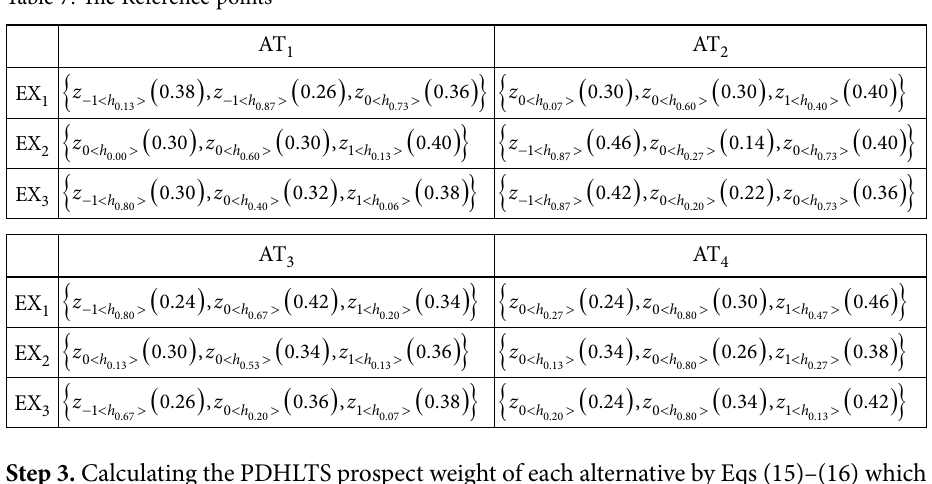
Table 8. The prospect weight of each alternative based on e 1 AT 1 AT 2 AT 3 AT 4 DP 1